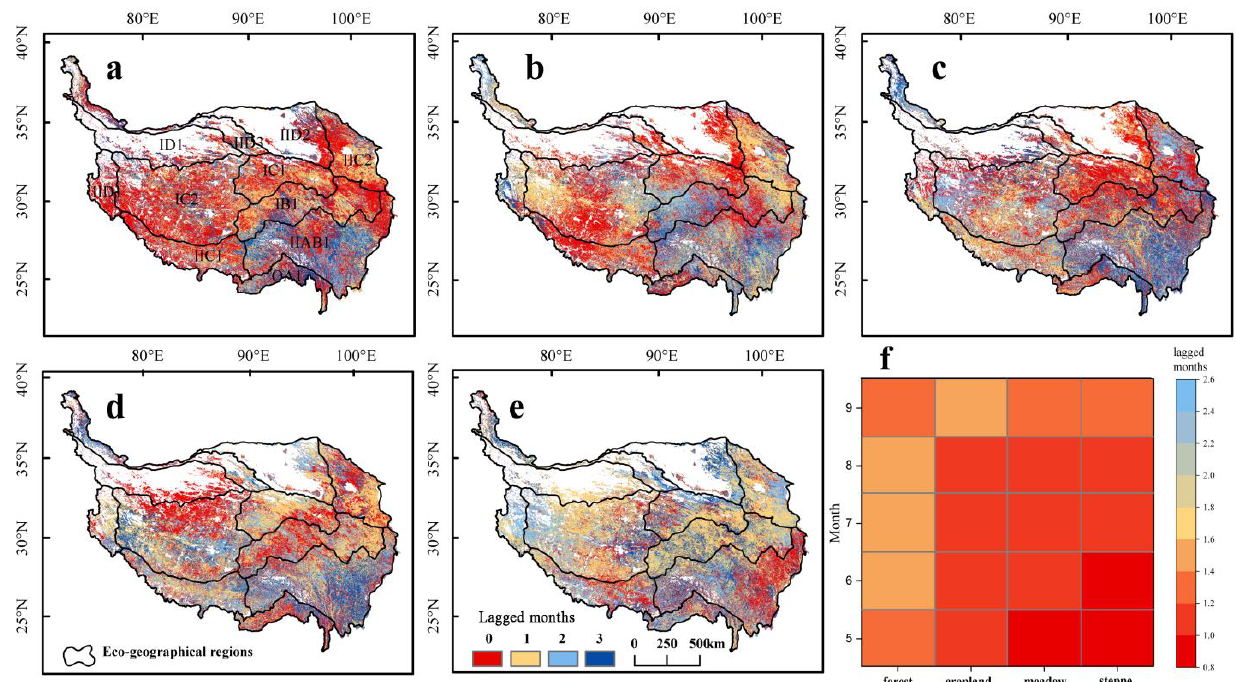
Figure 3. Spatial distribution of the largest correlation coefficient r max − lag between one-month SPEI and NDVI and significance ( p < 0.05) from 2000 − 2018. ( a ) May; ( b ) June; ( c ) July; ( d ) August; ( e ) September. The largest correlation coefficient r max − lag between SPEI and NDVI of different vegetation types on the QTP ( f ).